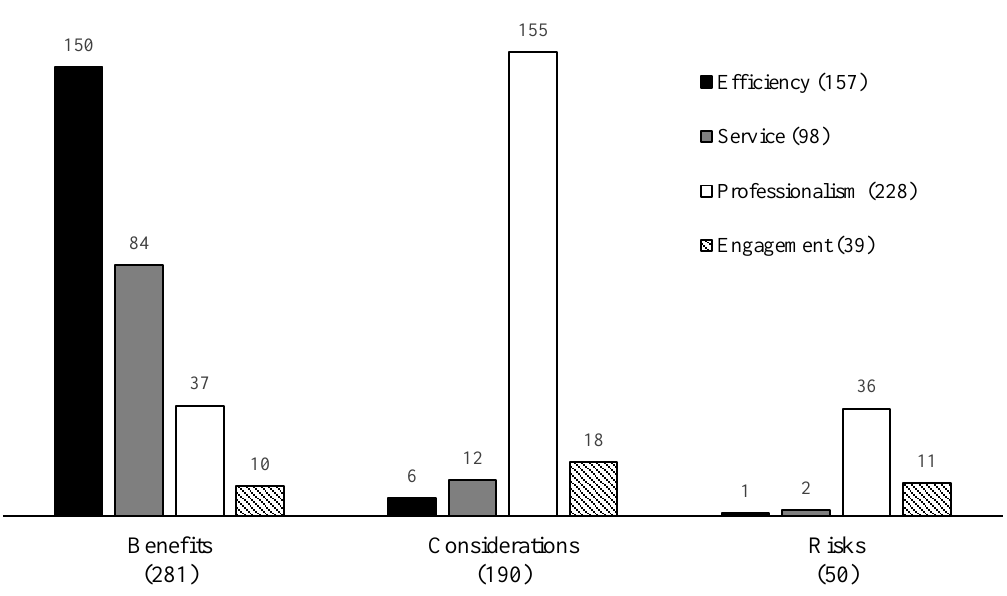
Fig. 1. The distribution of categories and value ideals associated with the use of AI (Toll et al.,